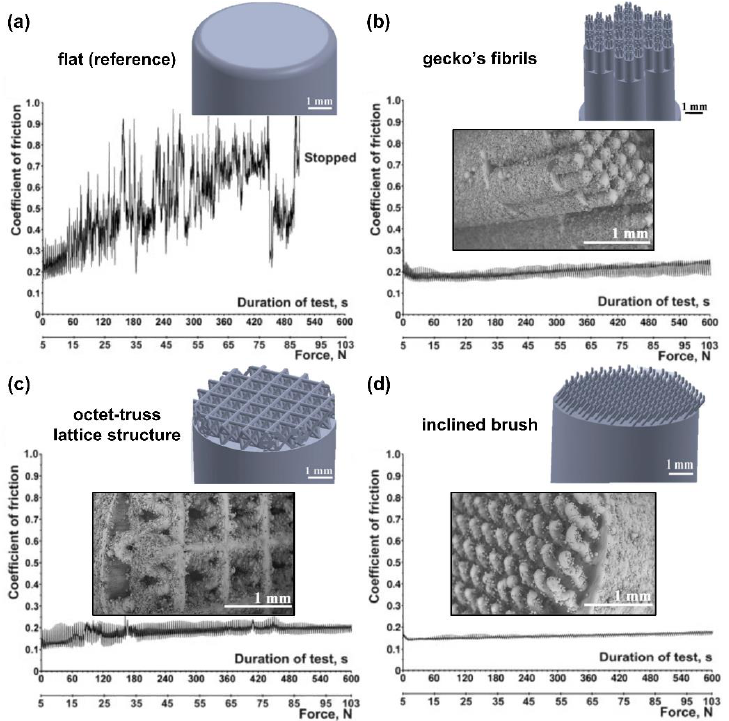
Figure 2. Coefficient of friction versus test duration and normal force of various surface patterns: ( a ) flat (reference), ( b ) gecko’s fibrils, ( c ) octet-truss lattice structure, ( d ) inclined brush. Redrawn from [105] with permission.